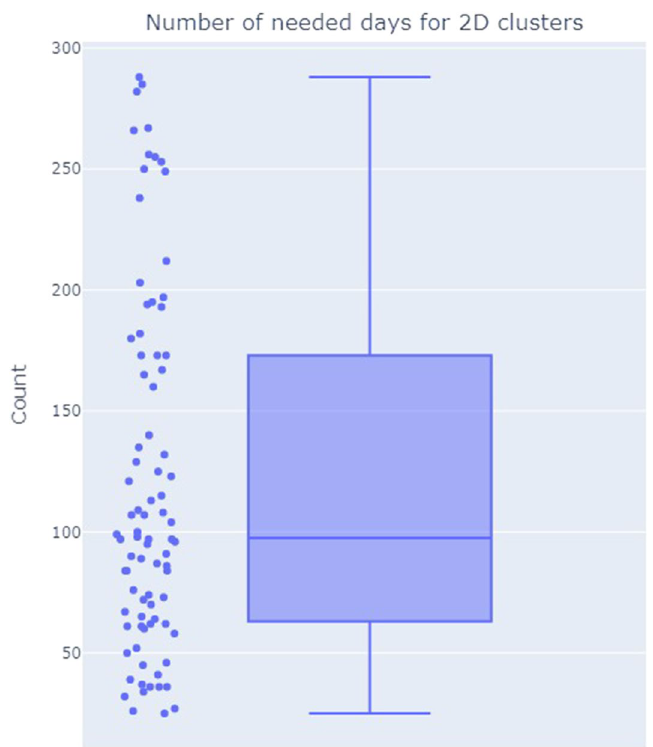
Fig. 8 Distribution of the convergence time in terms of the number of days in the 2-D clustering